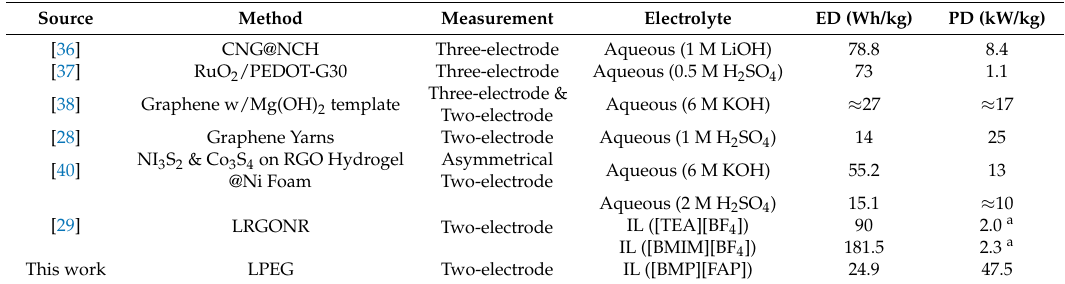
Figure 4. Ragone (power density vs energy density) performance plot of devices with graphite powder ( a ), LPEG with KOH as the electrolyte ( b ), 1-pyrene carboxylic-acid functionalized graphene with KOH as the electrolyte ( c ) [39], and LPEG with BMP-FAP as electrolyte devices ( d ). Table 2. A comparison of a variety of graphene-based device electrochemical power and energy